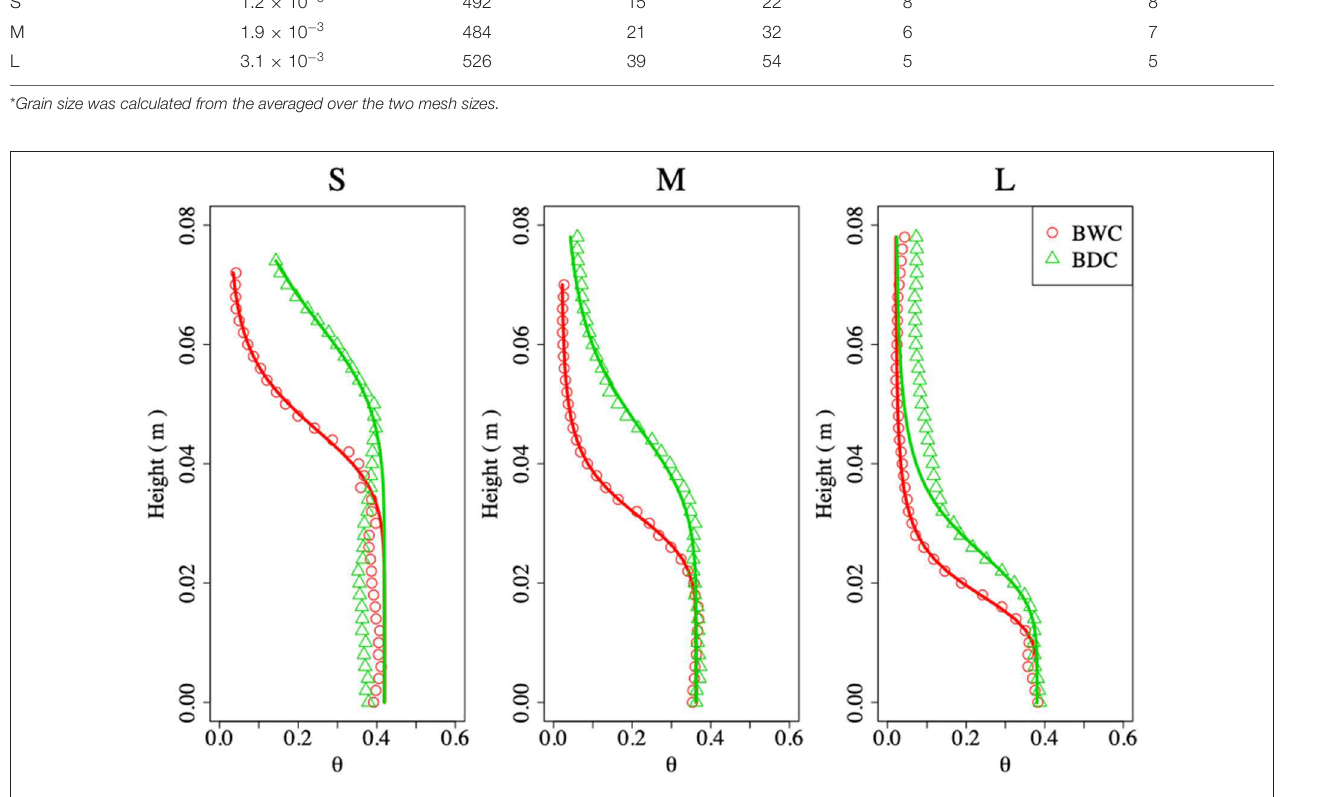
FIGURE 6 | Measurement results of boundary wetting curve and boundary drying curve for different grain sizes (S, M, L) (Equation 3). BWC, boundary wetting curve; BDC, boundary drying curve; θ , volumetric liquid water content. Red circles are measurement results of boundary wetting curve, and green triangles are measurement results of boundary drying curve. Red and green curves are fitting curves for Van Genuchten equation, respectively.